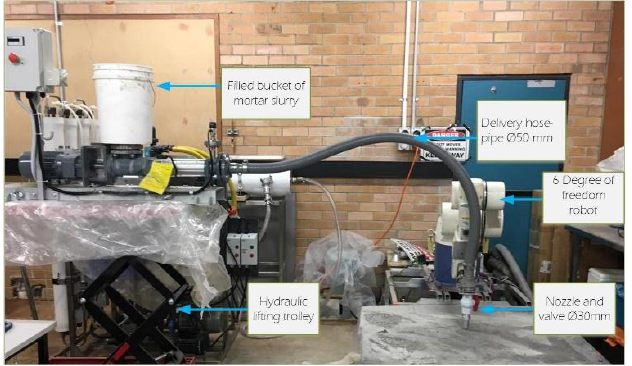
Figure 4. The final system with the progress cavity pump connected to the robot.